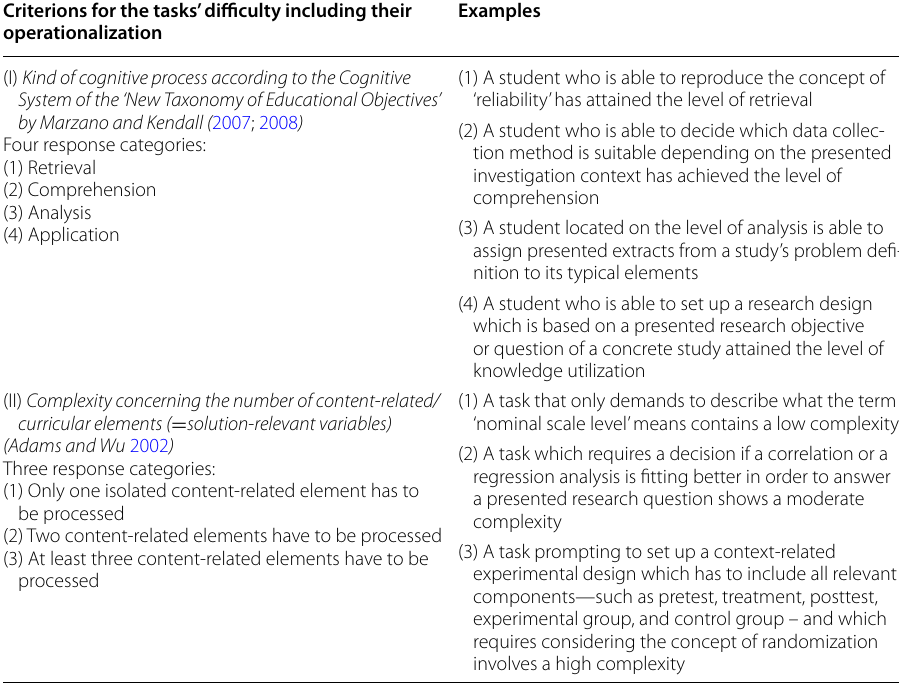
Table 6 Criteria for the tasks’ difficulty, including their operationalization and examples Criterions for the tasks’ difficulty including their operationalization